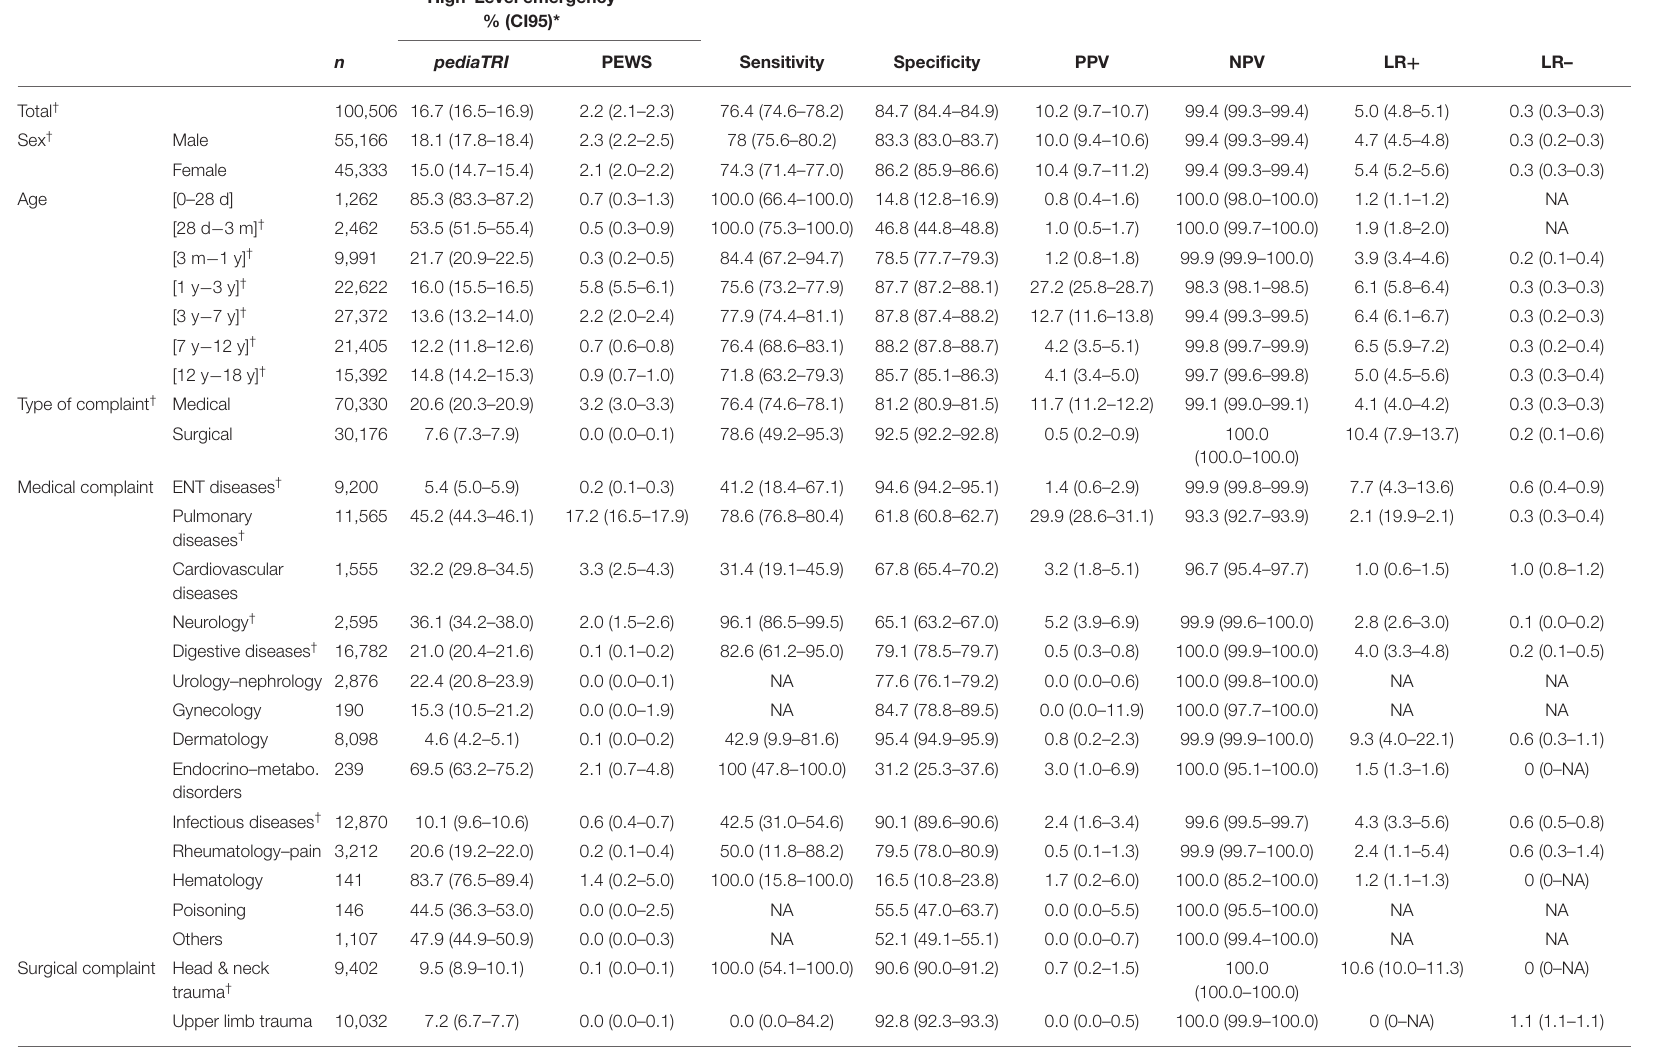
TABLE 4 | Sensitivity, specificity, predictive values and likelihood ratios of pediaTRI vs. PEWS (Continued on next